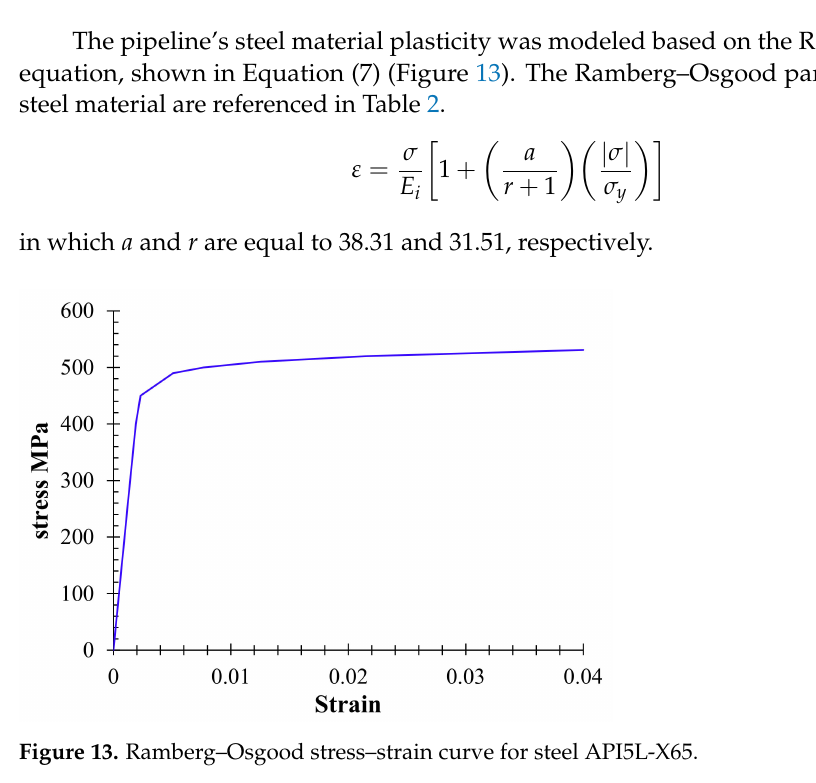
Figure 12. Equivalent nonlinear soil-pipe interaction springs in the beam–spring model. ( a ) Longitudinal, ( b ) Lateral, ( c ) Vertical.